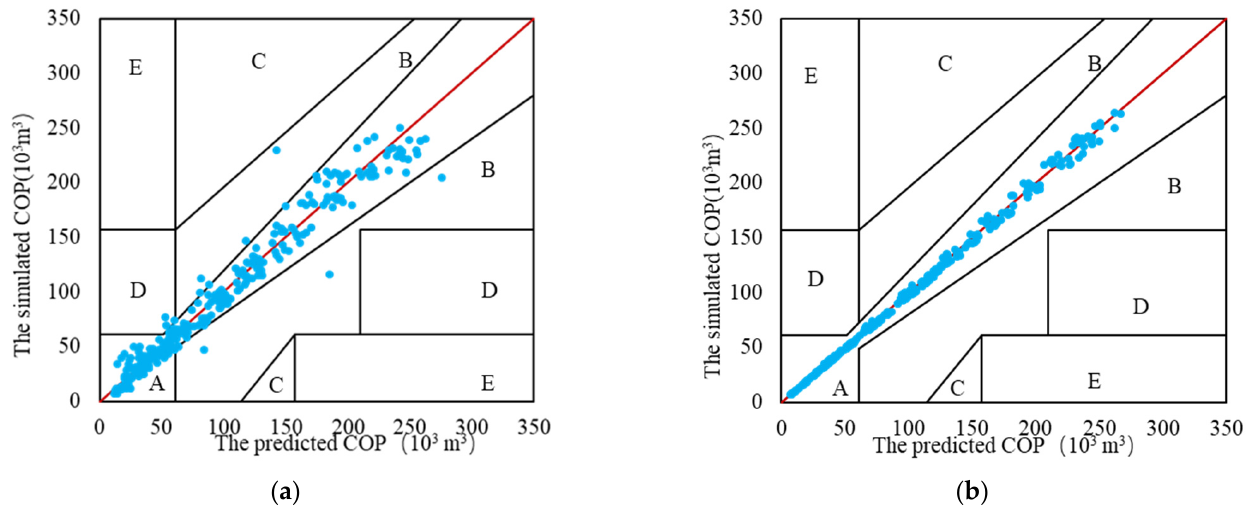
Figure 8. The Clarke error grids of the LM and PA-LM model: ( a ) LM model; ( b ) PA-LM